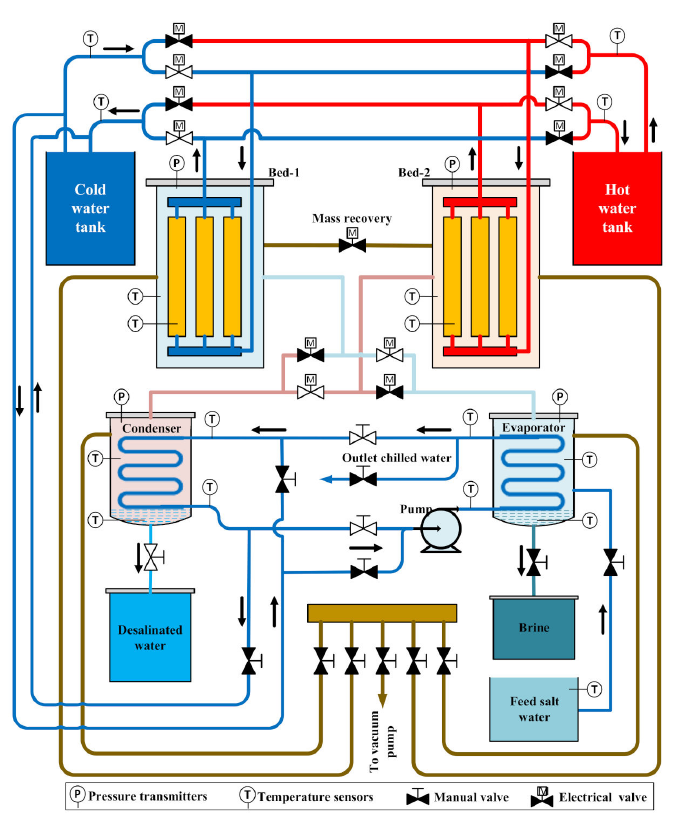
Figure 1. Schematic diagram of the adsorption water desalination